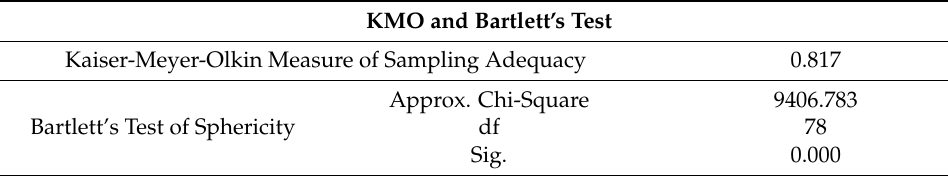
Table 5. Kaiser–Meyer–Olkin (KMO) and Bartlett’s test.